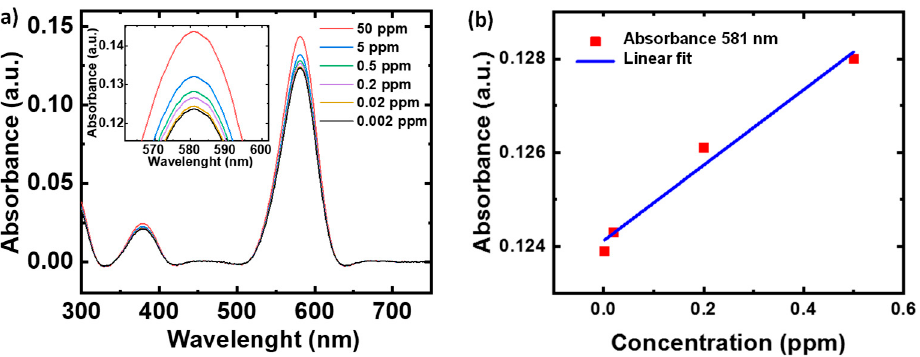
Figure 2. m-Cresol Purple dye sensitivity towards NO detection. ( a ) UV–Vis absorption curve of dye with change in NO concentration. Inset shows the magnified plot of the absorbance peak centered at 581 nm. ( b ) Corresponding calibration plot of dye in the detection range of 0.002–0.5 ppm.